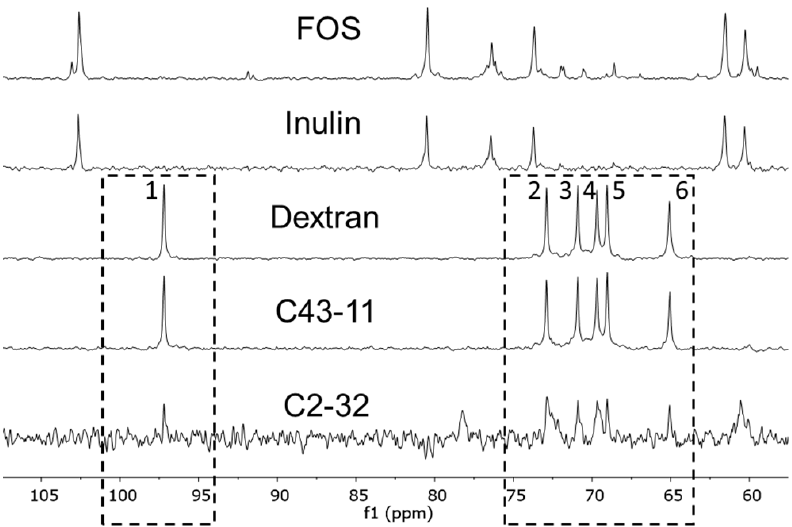
Figure 3. Comparison of typical 13 C{ 1 H} NMR spectra (D 2 O, 400 MHz, 303 K) of fructooligosaccharide (FOS), inulin, dextran (MW 270 kDa) and purified samples from C43-11 + S and C2-32 + S. The signals ascribed to the dextran structure are indicated in dashed squares.